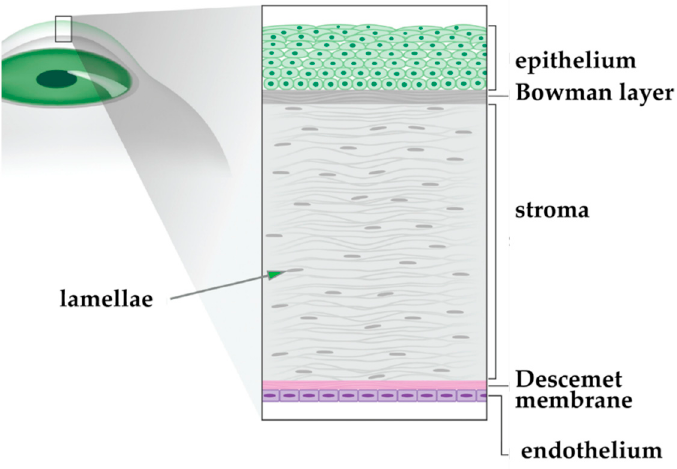
Figure 15. Illustration of corneal